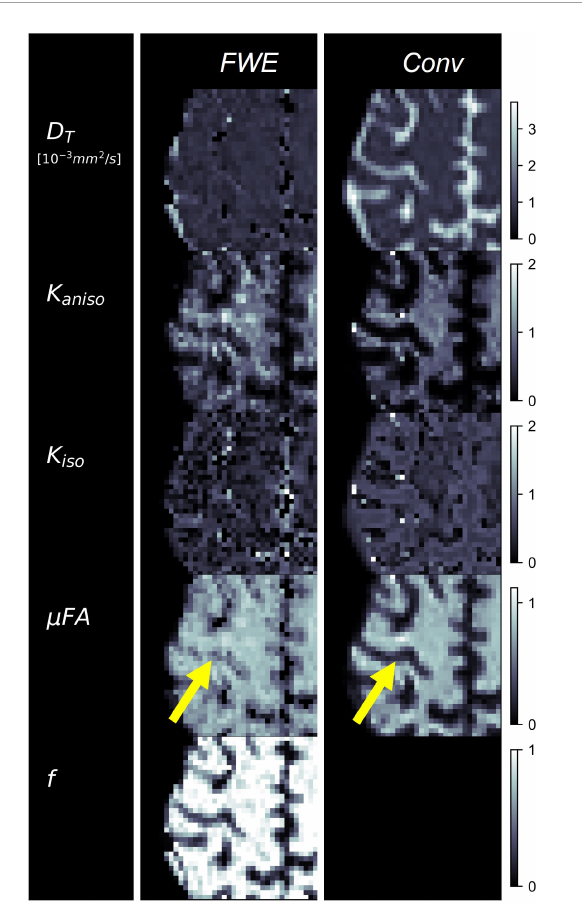
FIGURE6 Example cerebral cortex images of tissue diffusivity ( D T ), anisotropic kurtosis ( K aniso ), isotropic kurtosis ( K iso ), microscopic fractional anisotropy ( µ FA), and tissue volume fraction ( f ) measured in one of the healthy volunteers. The images on the left were computed using the free water elimination (FWE) method while those on the right were computed using the conventional (Conv) method. Note that D T is used interchangeably with D for the conventional method. The yellow arrow highlights a region in which a significant difference is observed between the FWE and conventional µ FA measurements due to high free water